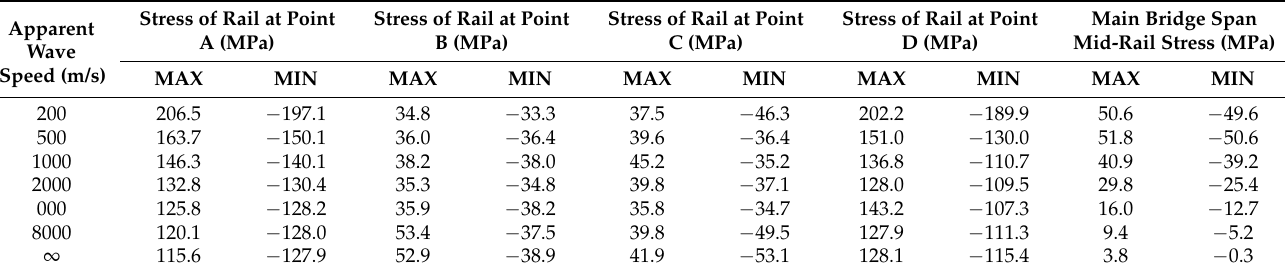
Figure 10. Rail stress at different apparent wave velocities. Table 4. Rail stress at different apparent wave